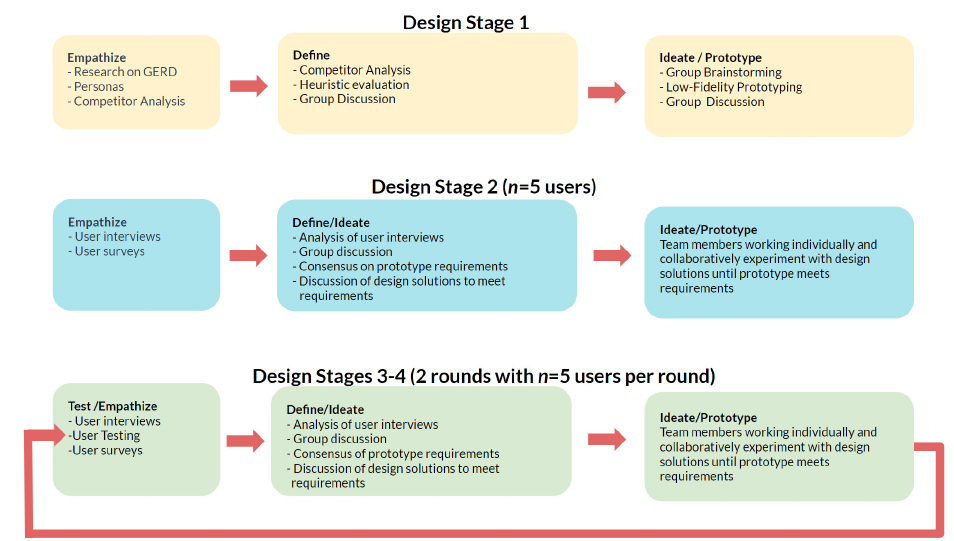
Figure 1. Rough map of the user-centered design thinking process behind GerdHelper, where design is iterative and design-thinking components are not strictly sequential or discrete.